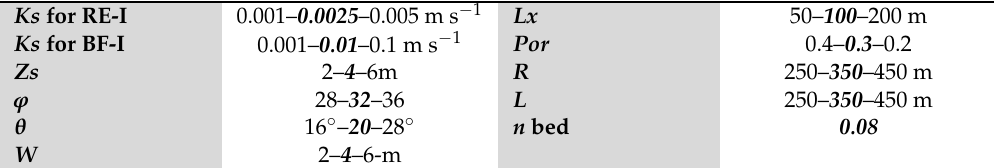
Table 3. Default values (bold italic) and maximum and minimum values of input parameters for overland flow erosion (RE-I) and bed failure (BF-I) triggering debris flows. Ks : Saturated hydraulic conductivity; Zs : Thickness of bed material; ϕ friction angle of material; θ : Slope angle of channel bed; W and Lx : width and length of channel bed respectively; Por : Available volumetric pore space; R : Radius of source area; L : Length of lateral slopes; n : Manning’s n of bed